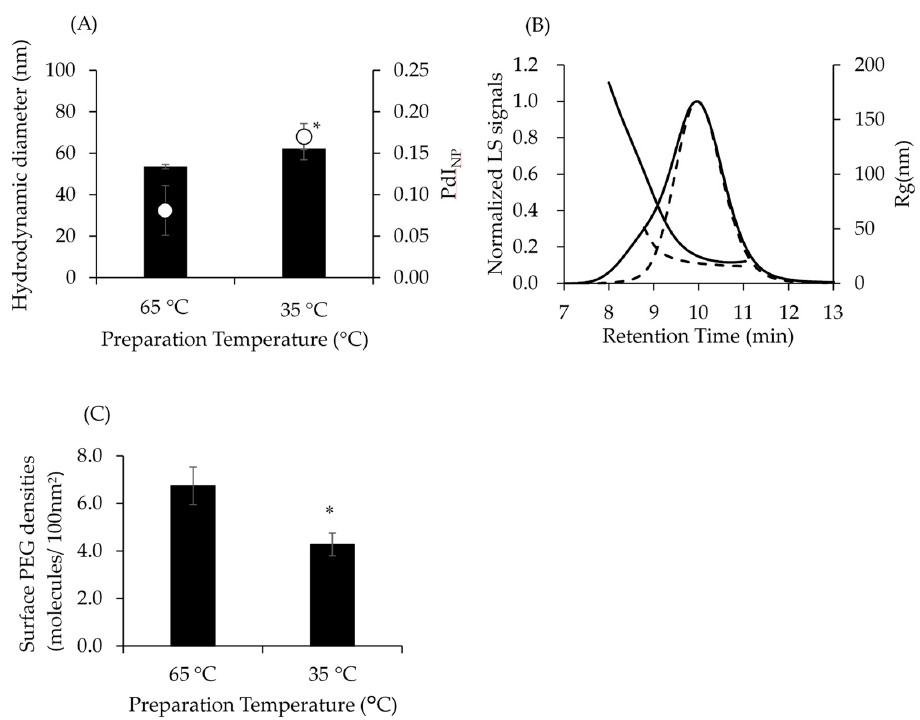
Figure 3. Characteristics of SC-PEG NPs prepared in different temperatures. Panel ( A ) shows the hydrodynamic diameters (D h ) and polydispersity index (PdI NP ). Solid bars and open circles indicate Dh (left axis) and PdI NP (right axis), respectively. Results are expressed as the mean ± standard deviation of three samples. The experiments were independently performed three times; * p < 0.05. Panel ( B ) represents the SEC–MALS chromatogram. Solid lines and dashed lines indicate NPs prepared at 35 °C and 65 °C, respectively. Left and right axis represents light scattering signals and gyration radius (R g ), respectively. Panel ( C ) shows surface PEG densities. Results are expressed as the mean ± standard deviation of three samples. The experiments were independently performed three times; * p < 0.05.